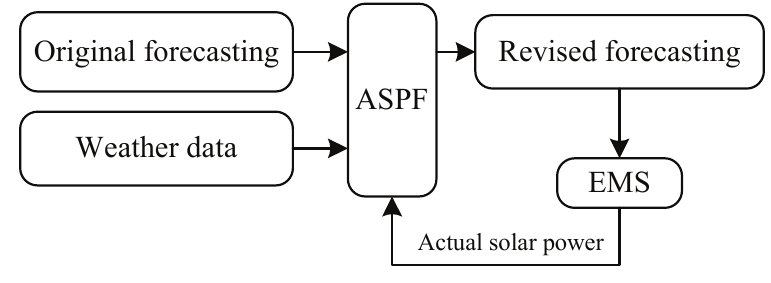
Figure 1. The function of